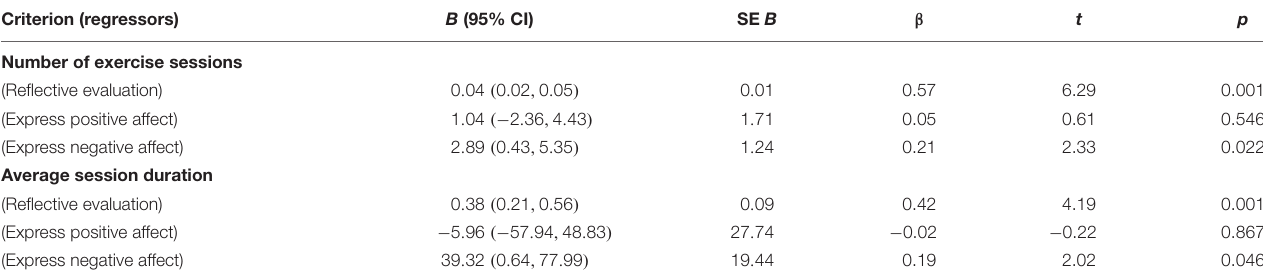
TABLE 2 | Results from two separate multiple linear regression